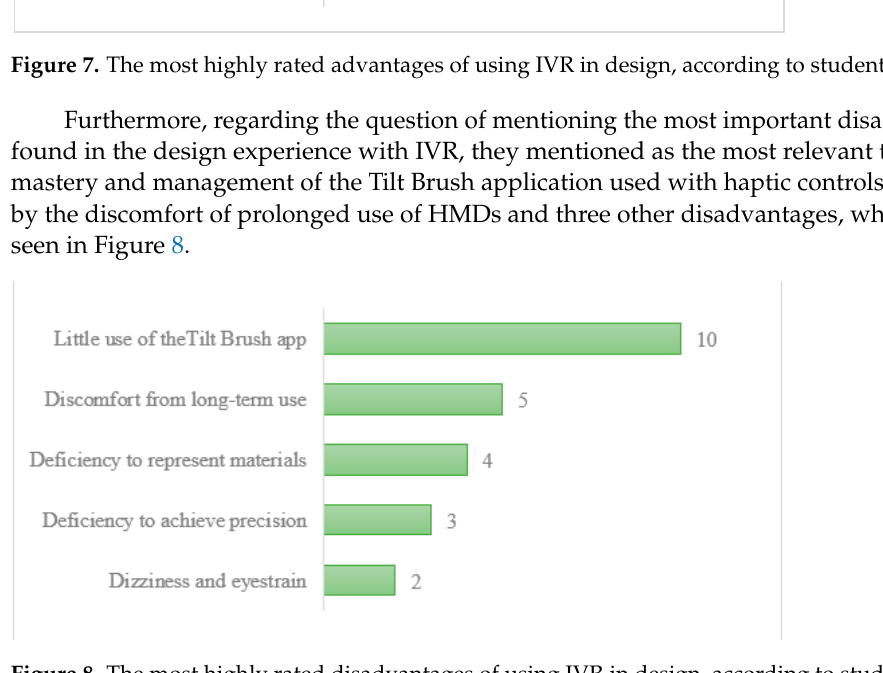
Figure 8. The most highly rated disadvantages of using IVR in design, according to students.